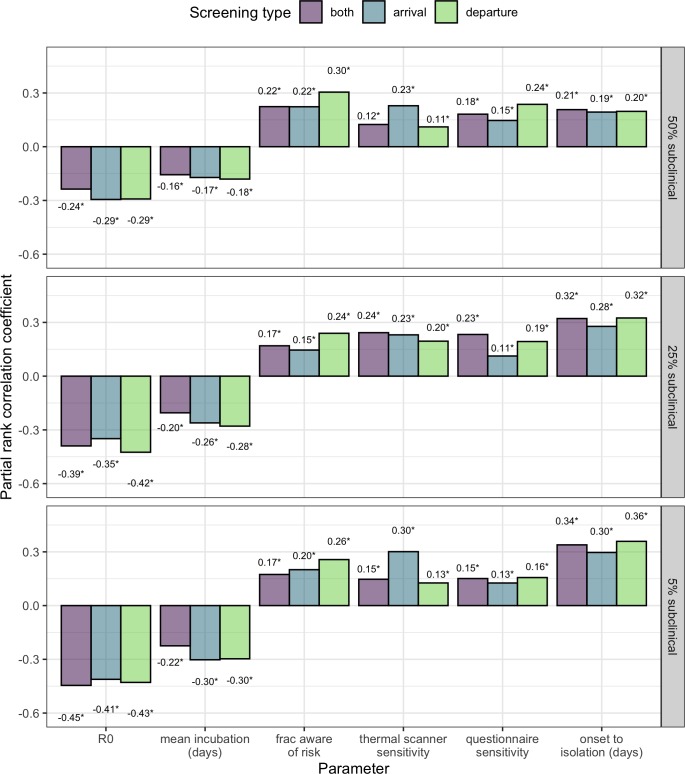
PRCC analysis comparing cases where 5%, 25% or 50% of cases are subclinical.(Middle panel is identical to Figure 4, but repeated for ease of comparison).